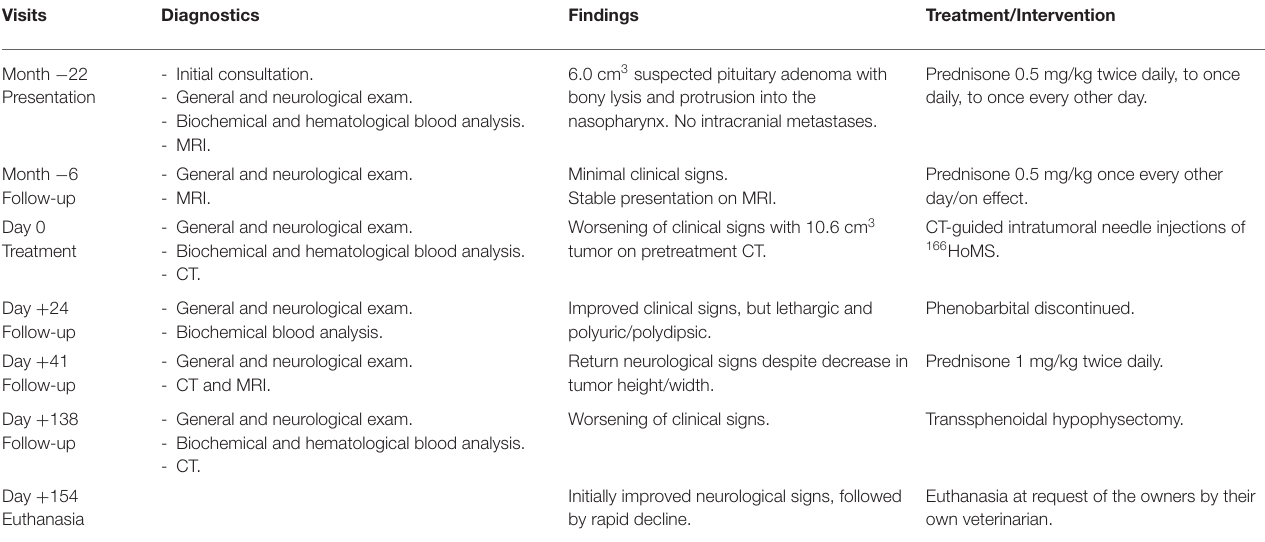
TABLE 1 | Timeline showcasing relevant data from episodes of care. Visits Diagnostics